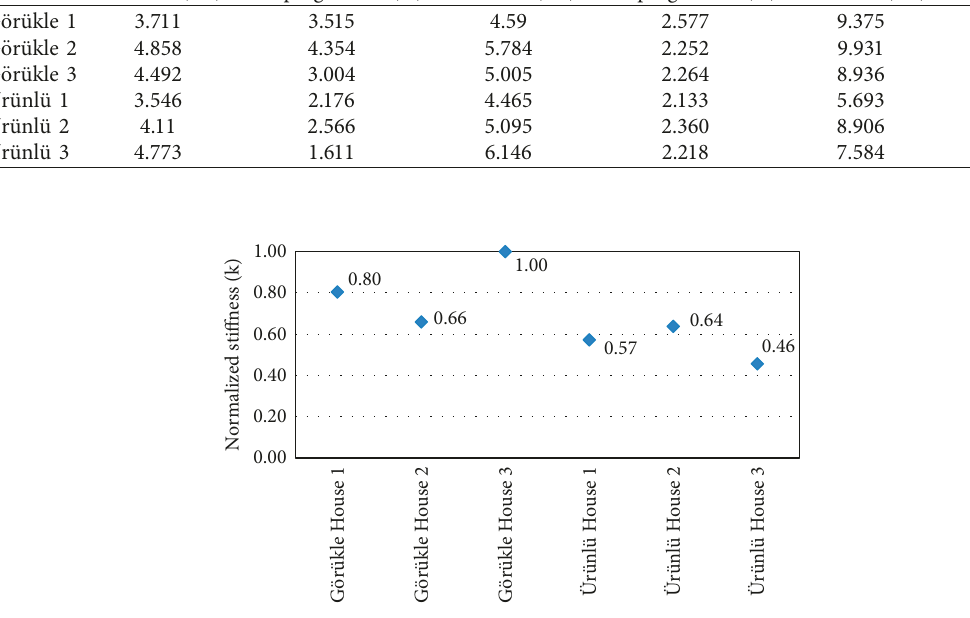
Table 4: The first three modes and damping ratios of the studied houses. Studied houses